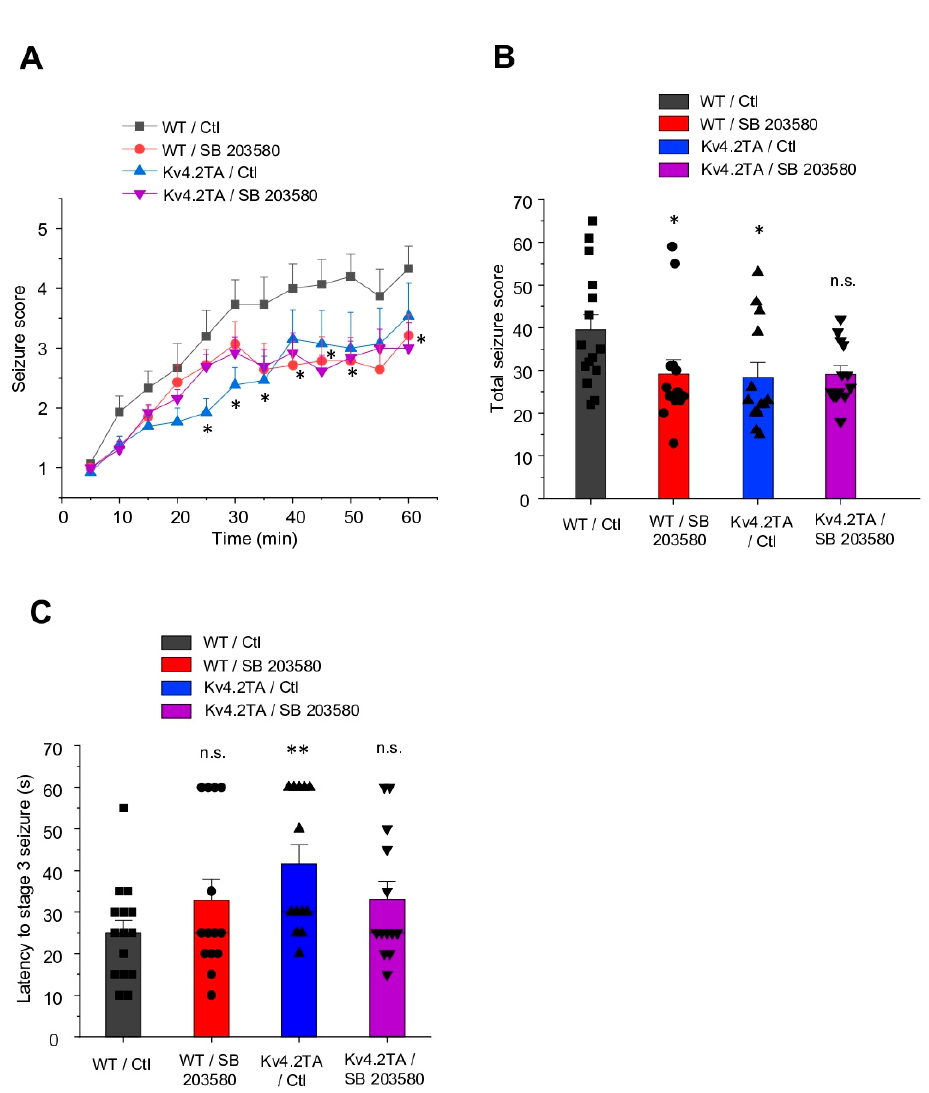
Figure 1. p38 mitogen-activated protein kinase (MAPK) contributed to kainic acid-induced seizure in WT mice but not Kv4.2TA mice. ( A ) Time course of mean behavioral seizure score following kainic acid injection. The mean behavioral seizure score was significantly reduced in Kv4.2TA mice compared to WT mice. Furthermore, p38 inhibitor SB 203580 significantly reduced behavioral seizure score following kainic acid injection in WT mice but not in Kv4.2TA mice, n = 13 – 15 for each group, two-way ANOVA, * p < 0.05. ( B ) Total behavioral seizure score for each group, n = 13 – 15 for each group, t -test, * p < 0.05. ( C ) Latency to stage 3 seizure for each group. n = 13 – 15 for each group, t -test, ** p < 0.01.